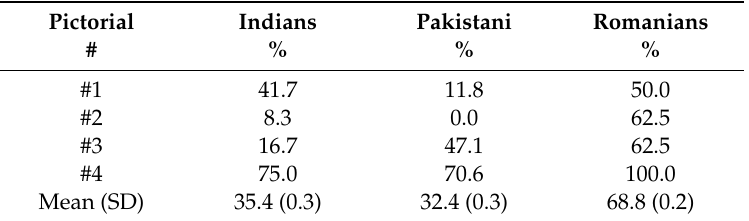
Table 4. Percentage of correct answers by nationality for the four safety pictorials